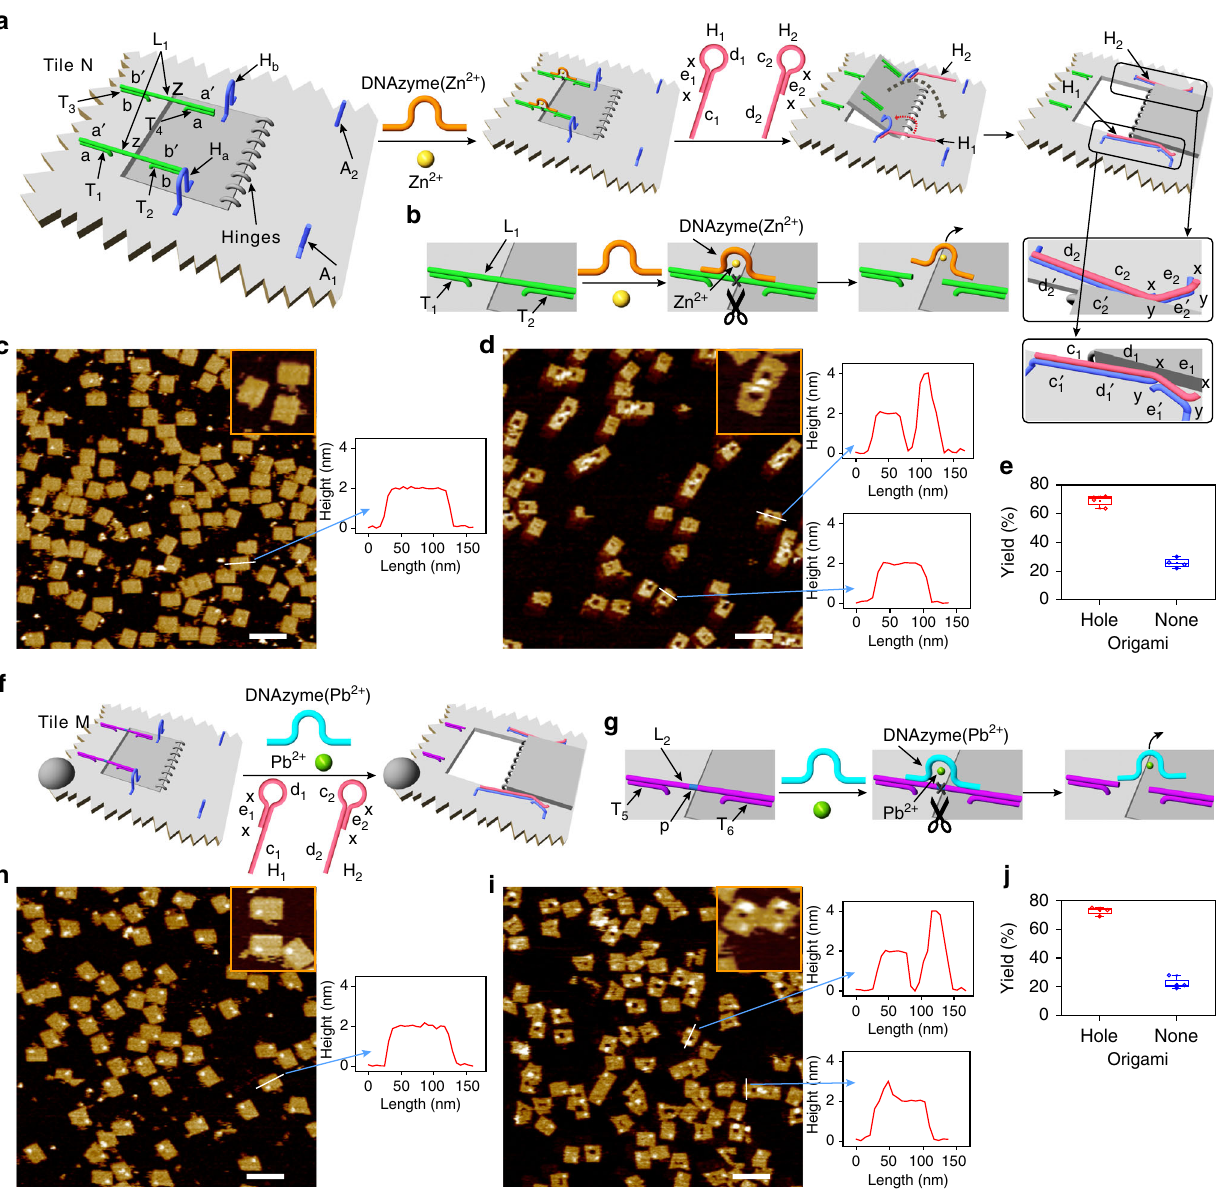
Fig. 1 DNAzyme-driven formation of nanoholes in origami tiles. a Schematic mechanistic formation of the nanohole in the origami tile N using the Zn 2 + -ion-dependent DNAzyme as unlocking catalyst. The origami tile includes a locked “ window ” domain linked to the origami scaffold by eight hinges, and is modi fi ed by two “ handles ” and two “ anchor ” tethers. Note that the scheme only shows the key part of the origami tile. b Schematic Zn 2 + -dependent DNAzyme-driven unlocking of the “ window ” by the cleavage of the substrate using the hairpin-assisted opening of the “ window ” through hybridization to the handles and its pulling to the anchoring sites. c AFM image corresponding to the locked con fi guration of origami tiles. d AFM image corresponding to the unlocked origami tiles that include the nanoholes. Insets: enlarged structures of the respective tiles. The AFM images are accompanied by respective cross-section analyses of the tiles con fi rming the active formation of the nanoholes. Source data are provided as a Source Data fi le. e Statistical analysis of the nanohole-functionalized tiles generated by the Zn 2 + -ion-dependent DNAzyme (for details, see Supplementary Table 1). f Schematic mechanistic formation of the nanohole in the origami tile M using the Pb 2 + -ion-dependent DNAzyme as unlocking catalyst. The origami tile is labeled with a four- hairpin label (marked with a hemispheroid) to identify the tile. g Schematic Pb 2 + -ion-dependent DNAzyme-driven unlocking of the “ window ” by the cleavage of the ribonucleobase-modi fi ed substrate, associated with the origami tile. h AFM image corresponding to the origami tiles prior to the unlocking process. i AFM image of the origami tiles after the Pb 2 + -ion-dependent DNAzyme-driven unlocking of the “ window ” . Insets correspond to enlarged structures of the respective tiles. Cross-section analyses con fi rm the structural features of the labeled nanohole-modi fi ed tiles. Source data are provided as a Source Data fi le. j Statistical analysis of the “ nanohole ” -functionalized tiles generated by the Pb 2 + -ion-dependent DNAzyme (for details, see Supplementary Table 4). Error bars indicate the SD from the analyses of four imaged areas (2 μ m × 2 μ m). Scale bars: 200 nm (Supplementary Figs. 3 and 4, and Supplementary Tables 2 and 3; are essential to unlock the “ window ” and to generate the nano- in addition, Supplementary Fig. 5 provides a statistical analysis of holes. In the presence of Zn 2 + ions only, a low yield (ca. 8%) of the results according to Student ’ s T -test). Further support for the open nanoholes are observed, and in the presence of H 1 / H 2 , only no nanohole-containing origami structures are detected DNAzyme-triggered unlocking of the “ window ” domain, and the NATURE COMMUNICATIONS| (2019) 10:4963